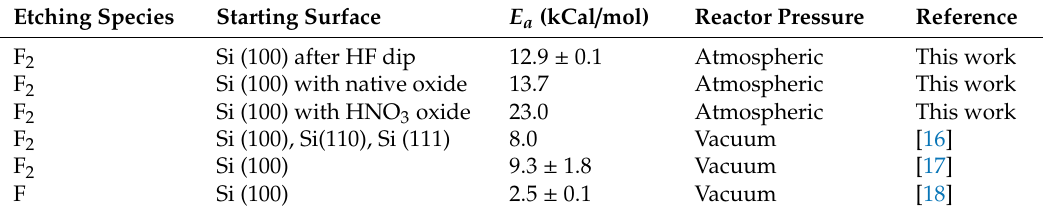
Table 2. Comparison of E a of F 2 -Si etching estimated in this section to those measured by other authors in various conditions. No previous account of estimation of E a is available for F 2 -Si etching in atmospheric pressure (Atm.) conditions.